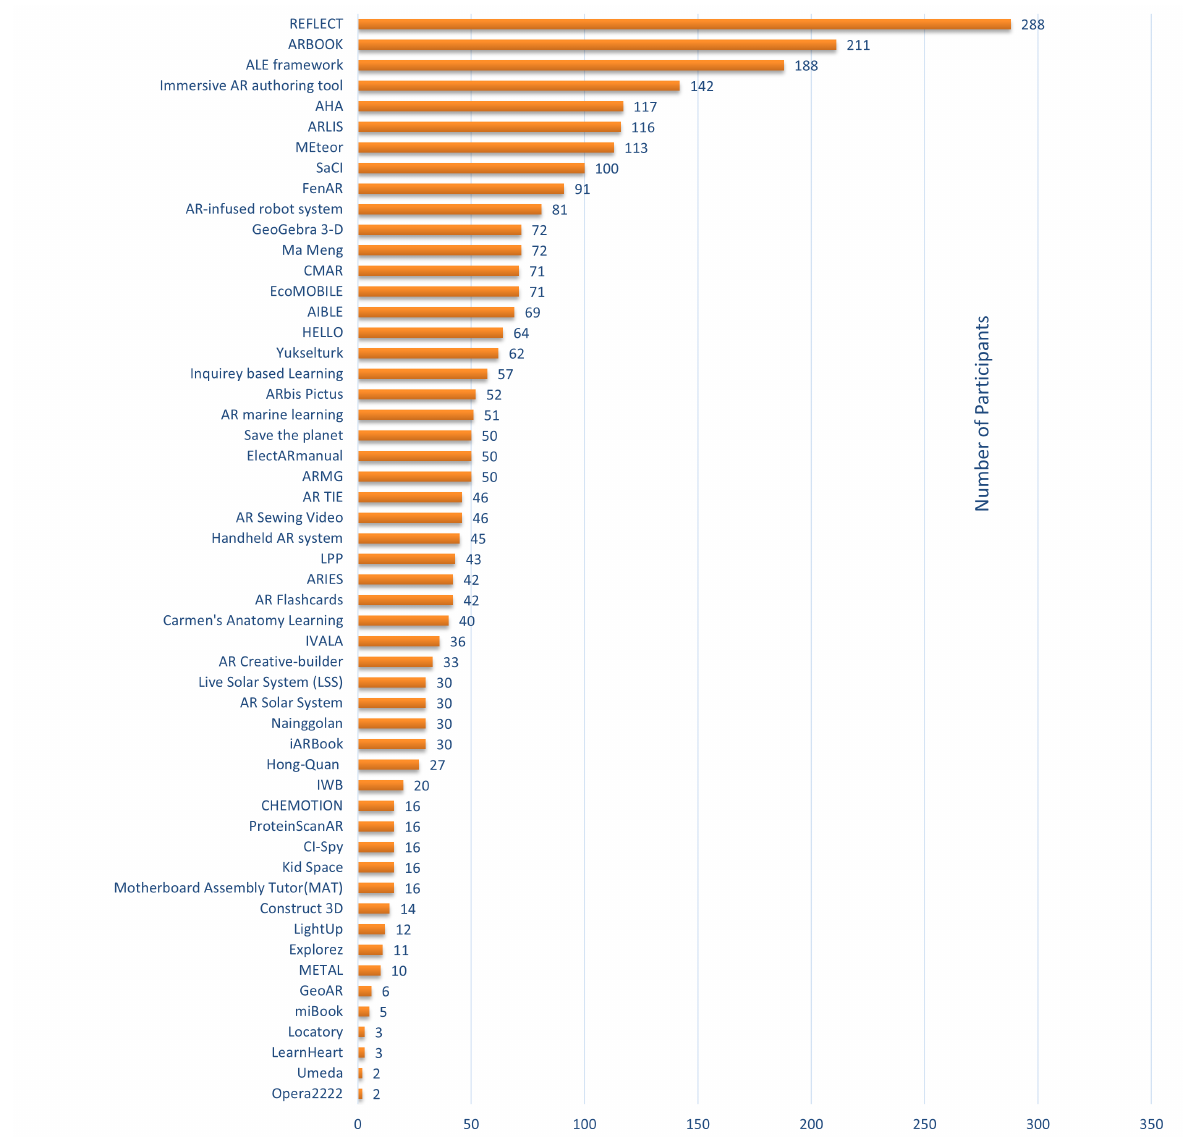
Figure 5. AR studies analysis according to the scale of experiments